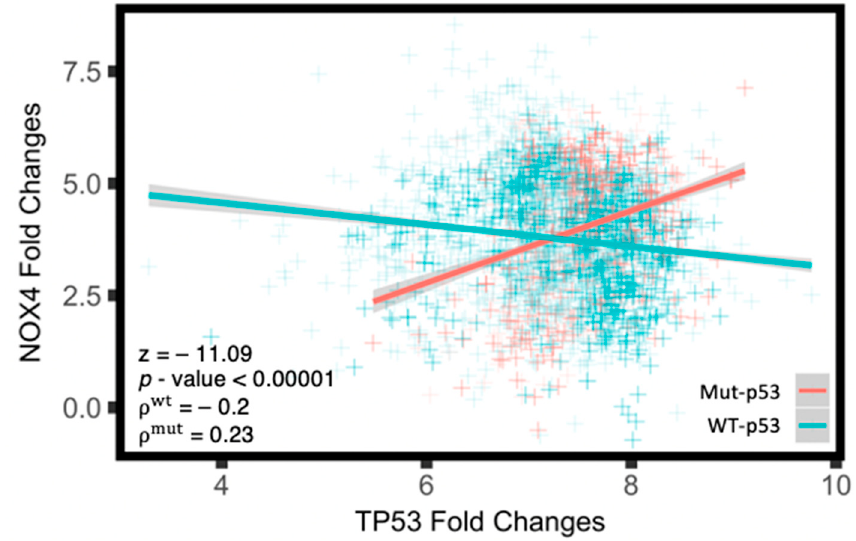
Figure 3. Mut-p53 mRNA positively correlate with NOX4 mRNA in the Pan-Cancer cohort. The Preliminary Pan-Cancer cohort was divided into patients with WT- TP53 or Mut- TP53 , and a scat- terplot was generated to visualize the relative mRNA (RSEM) values of p53 and NOX4. Linear regression was used to assess for broad correlations followed by Spearman’s test to calculate the ρ values, and two-tail Fisher’s r-to-z transformation to assess for the significance in ρ value difference. n WT-p53 = 2368, n mut-p53 =